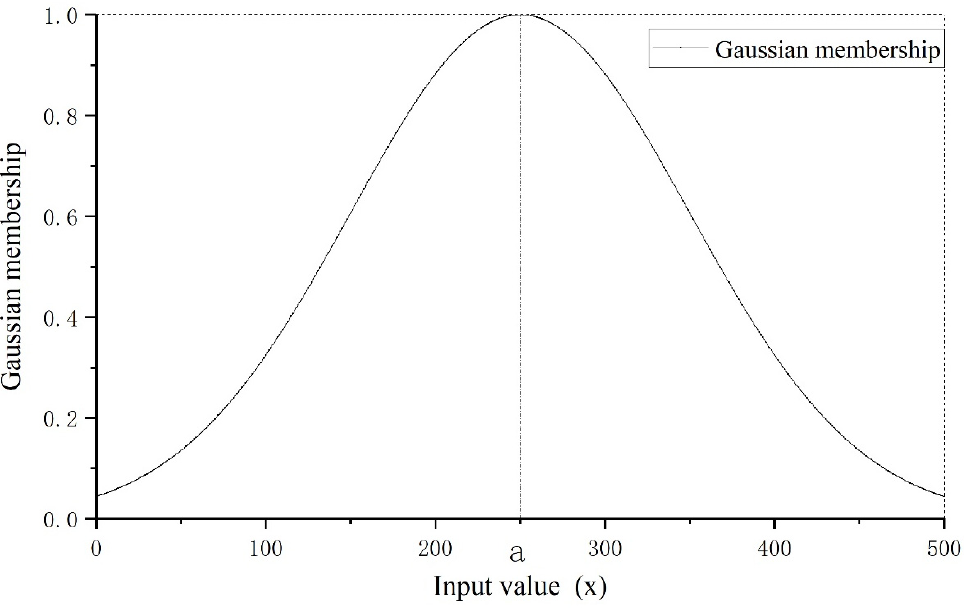
Figure 5. Curve of the Gaussian membership function.